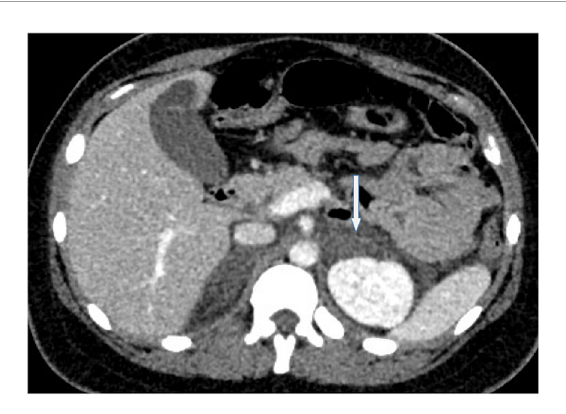
FIGURE1 A representative image of adrenal glands with computed tomography. The axial un-enhanced computed tomography performed at time 0 shows enlarged and ill-defined adrenal glands and fluid film with a mean density of 50 Hounsfield Unit.